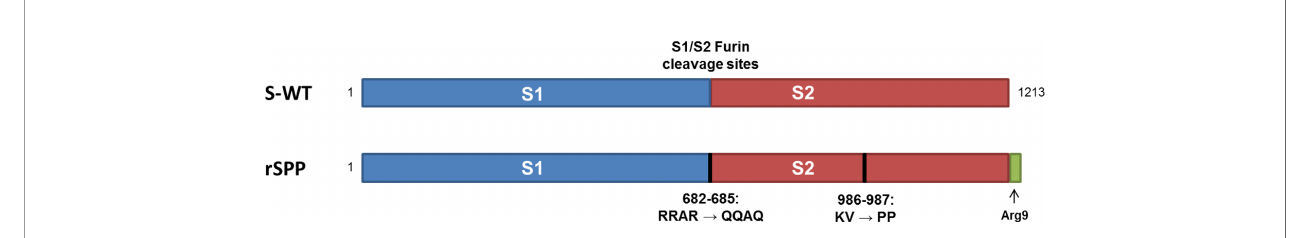
antibody ( Figure 2E ). The harvested sample was puri fi ed using an ÄKTA Pilot 600R system. The results of the ELISA assay also indicated that the puri fi ed protein concentration was 21.4 ± 0.18 g per batch with 96.56% purity ( Figure 2F ). In addition, residual host cell proteins and DNA were not detected in the puri fi ed S protein (data not shown).